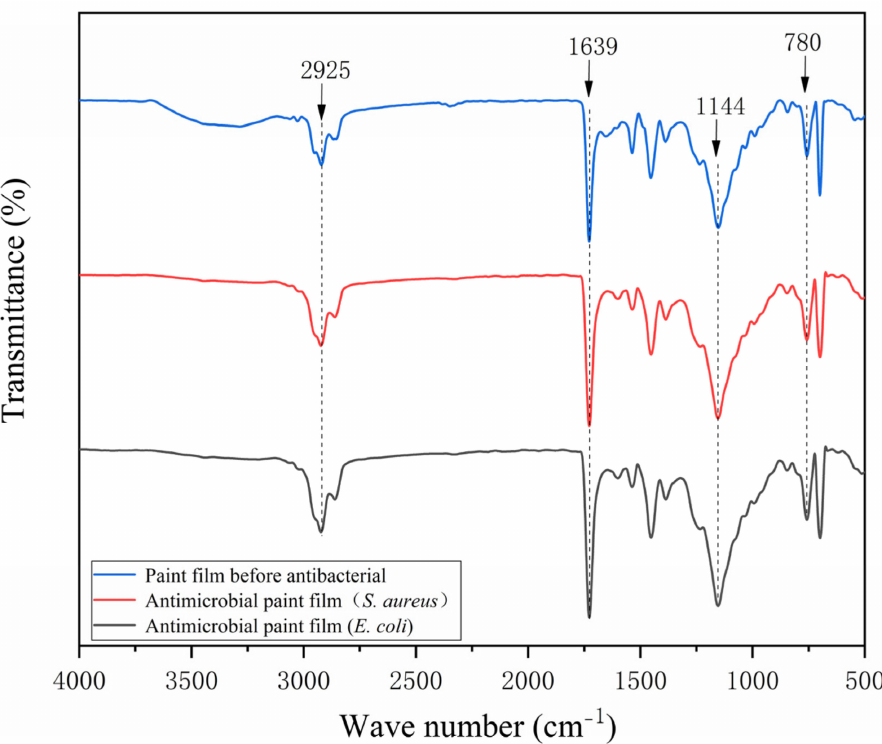
Figure 15. Infrared spectrum of 0# before and after antibacterial test.